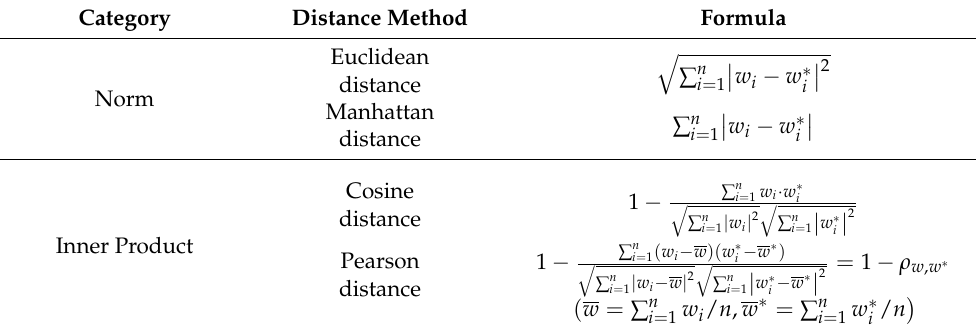
Table 1. Distances for the portfolio composition evaluation.